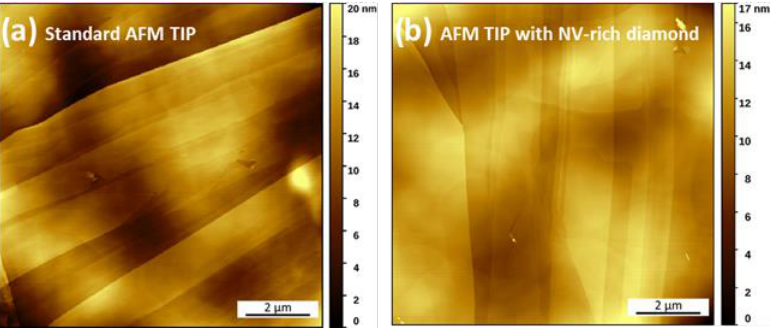
Figure 7. ( a ) HOPG image obtained using typical AFM probe (PPP-ContPt) without any additional processing. Typical RMS roughness is 3.47 nm ( b ) AFM image obtained using the AFM probe with NV-rich nanodiamond particle as a scanning tip. Typical RMS roughness is 2.23 nm.